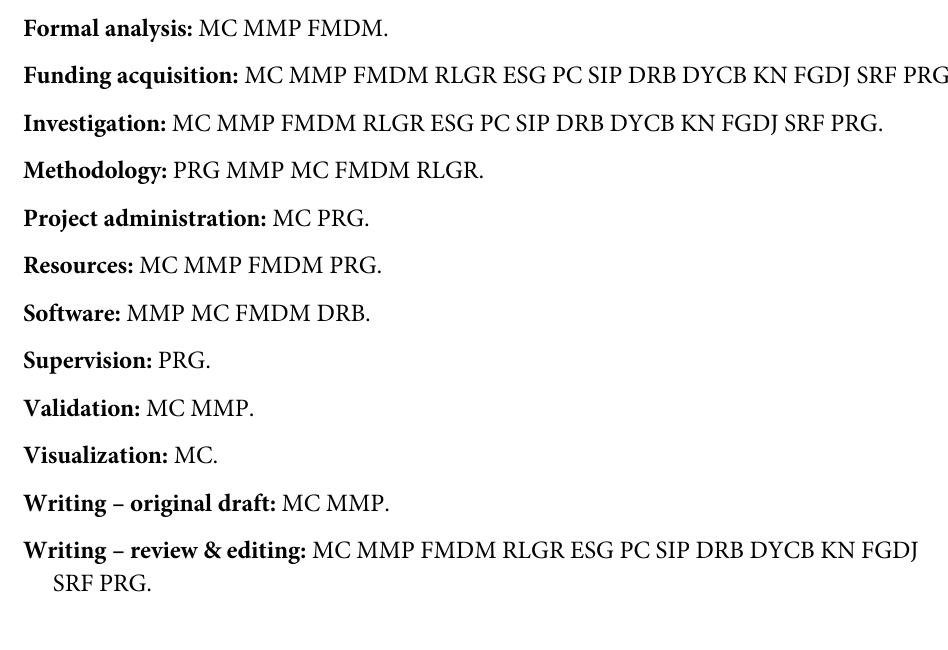
S1 Table. Characterization of the 18 systems encompassing six levels of organization con- sidered in this study and the biological entities or processes depicted by their network